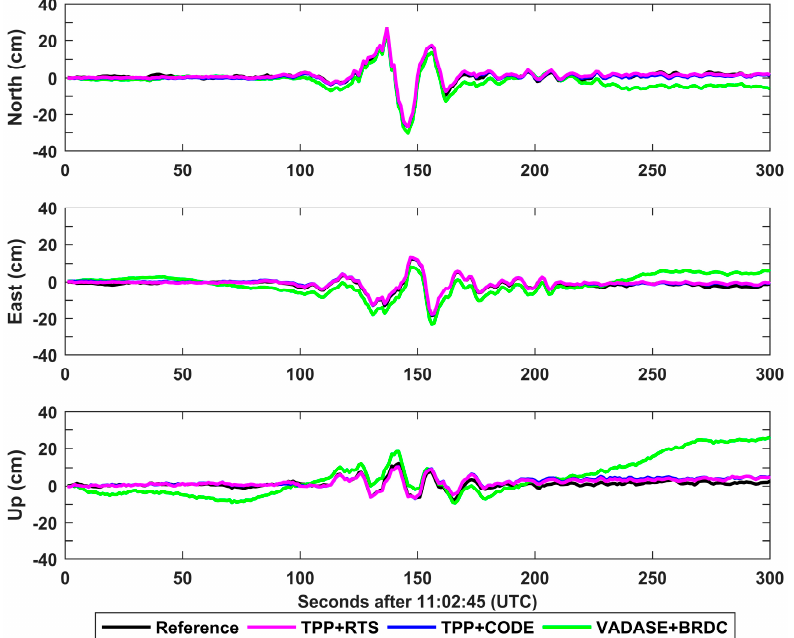
Figure 9. The retrieved coseismic displacements in north, east and up directions for different schemes at station WRPA.